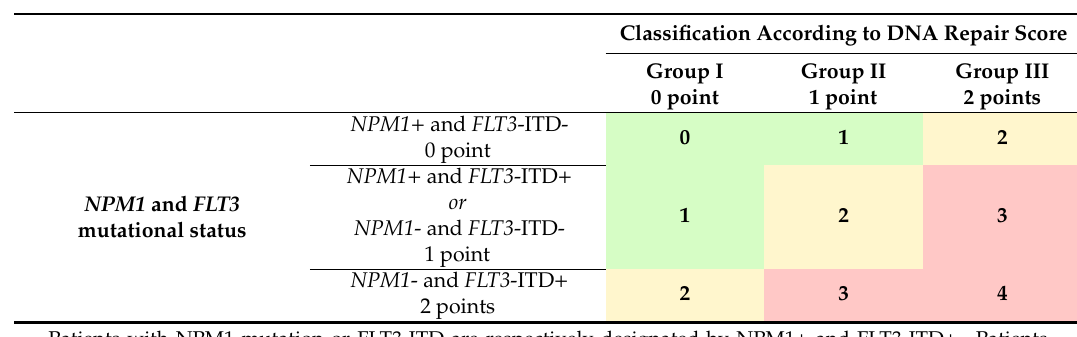
Table 4. DNA repair score and NPM1 / FLT3 mutational status combination to establish a global prognosis score in CN-AML. Patients were classified according to DNA repair score risk group (I, II or III) and NPM1 / FLT3 mutational